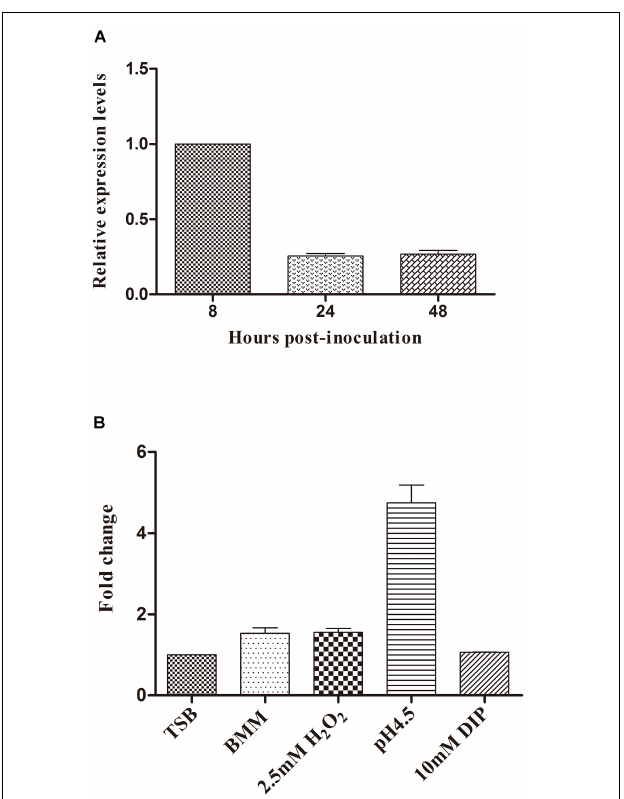
FIGURE 4 | Expression pattern of BASI74 in B. abortus 2308. (A) Expression levels of BASI74 at different growth stages in TSB medium. (B) Expression levels of BASI74 under different stress conditions. B. abortus 2308 from a single clone was grown for 48 h in TSB medium and then cultured in TSB (pH 4.5), TSB + 10 mM 2,2 (cid:48) -dipyridyl, BMM ( Brucella minimum medium) for 4 h or in TSB + 2.5 mM H 2 O 2 for 30 min. The expression levels of BASI74 under different stress conditions were compared to samples cultured in TSB medium. DIP stands for 2,2 (cid:48)